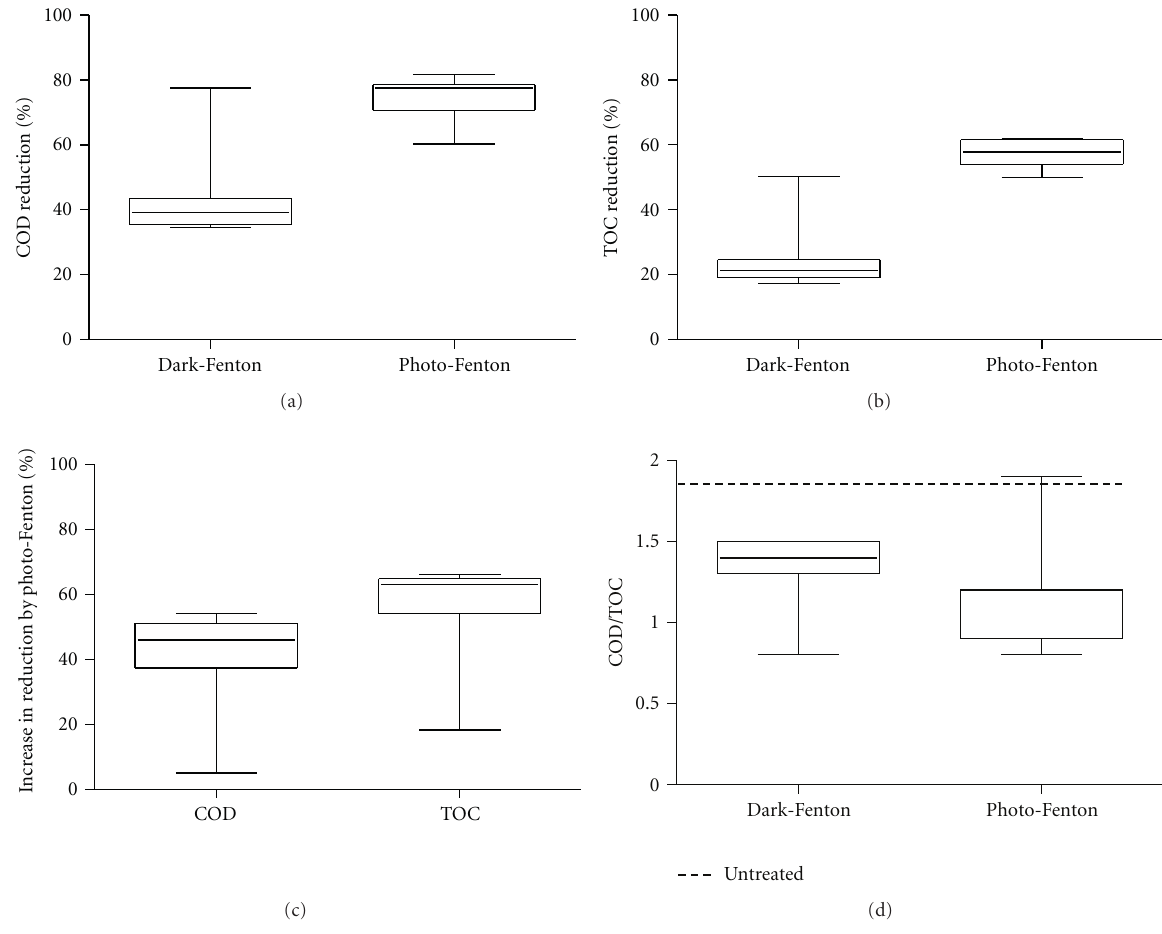
Figure 3: Boxplots built up with data from COD and TOC values obtained with dark-Fenton and photo-Fenton treatments. (a) COD reduction (in %) with both treatments; (b) TOC reduction (in %) with both treatments; (c) increase (in %) in the percentage of COD and TOC reduction by photo-Fenton compared to dark-Fenton; (d) changes in COD/TOC ratio due to di ff erent